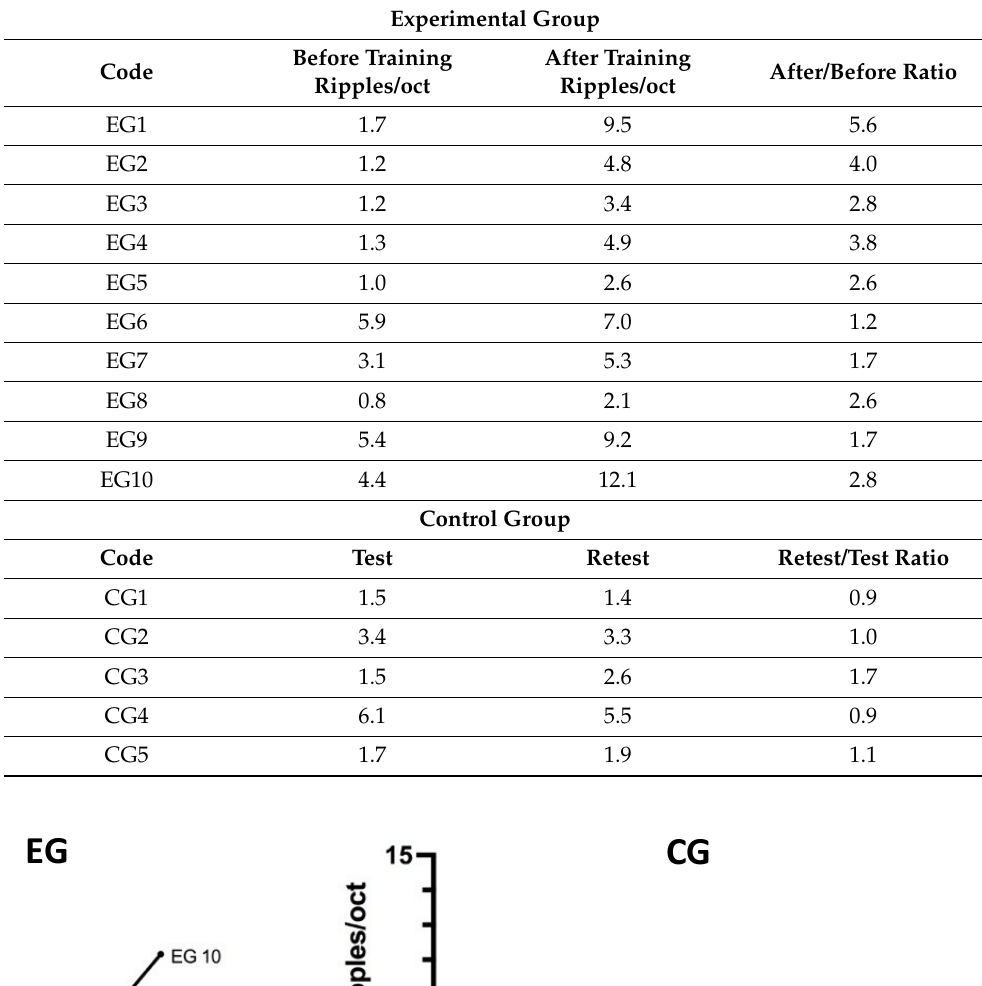
Table 2. Ripple density resolution data.